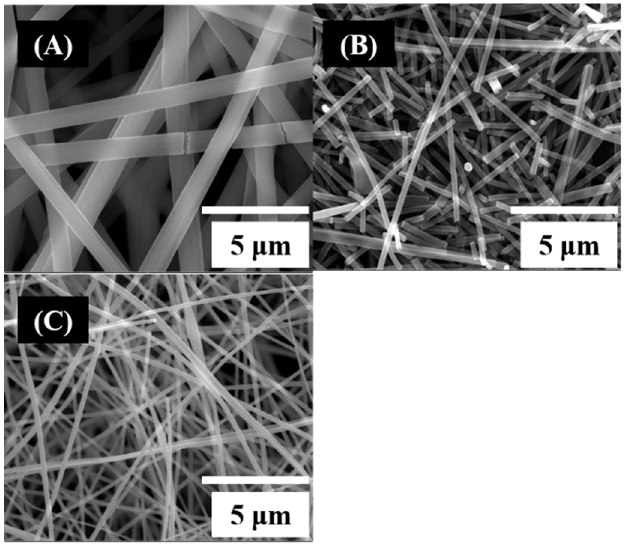
Figure 6. FE-SEM images of electrospinning TiO 2 /ZnO nanofibers: ( A ) 21 wt %, ( B ) 28 wt %, and ( C ) 35 wt %.